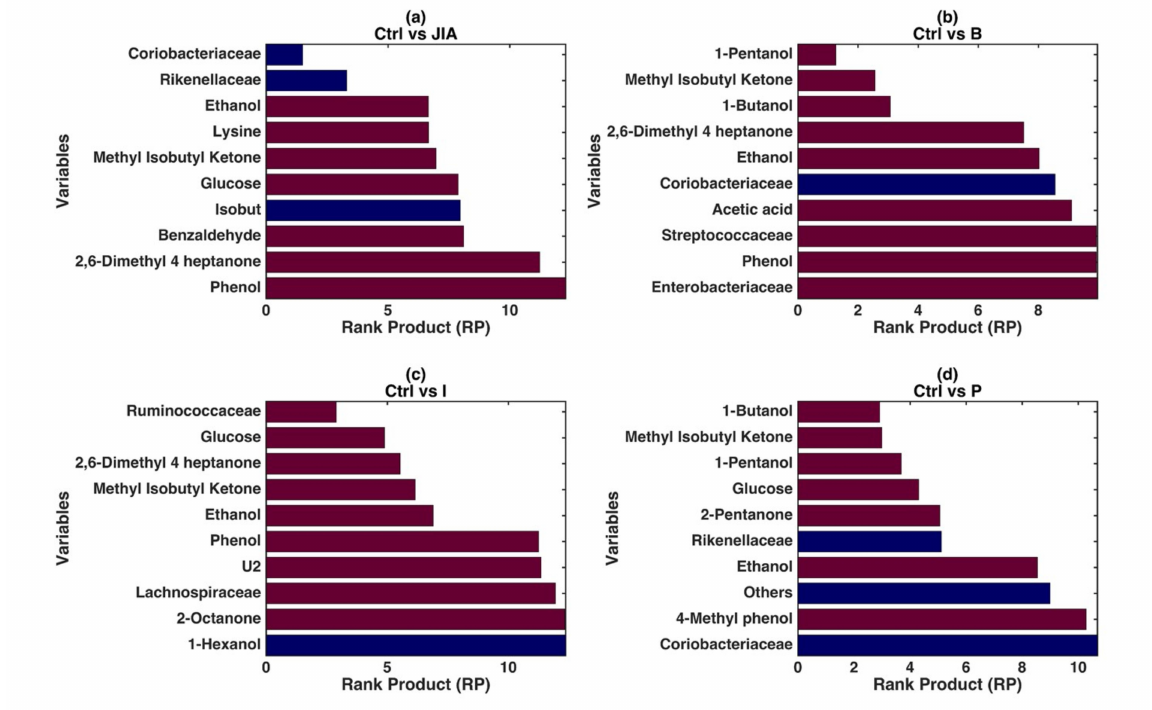
Figure 2. PLS-DA modeling on the low-level fused data. Graphical illustration of the variables significantly contributing to the definition of the single models based on the values of RP resulting from the repeated DCV procedure. The four di ff erent panels show the RP values for the models: ( a ) CTRLs vs. JIA; ( b ) CTRLs vs. JIA Baseline; ( c ) CTRLs vs. JIA Inactive; ( d ) CTRLs vs. JIA Persistent. In each panel, the color of the bars indicates whether, on average, the variable is higher (red) or lower (blue) in the specific JIA disease stage with respect to the